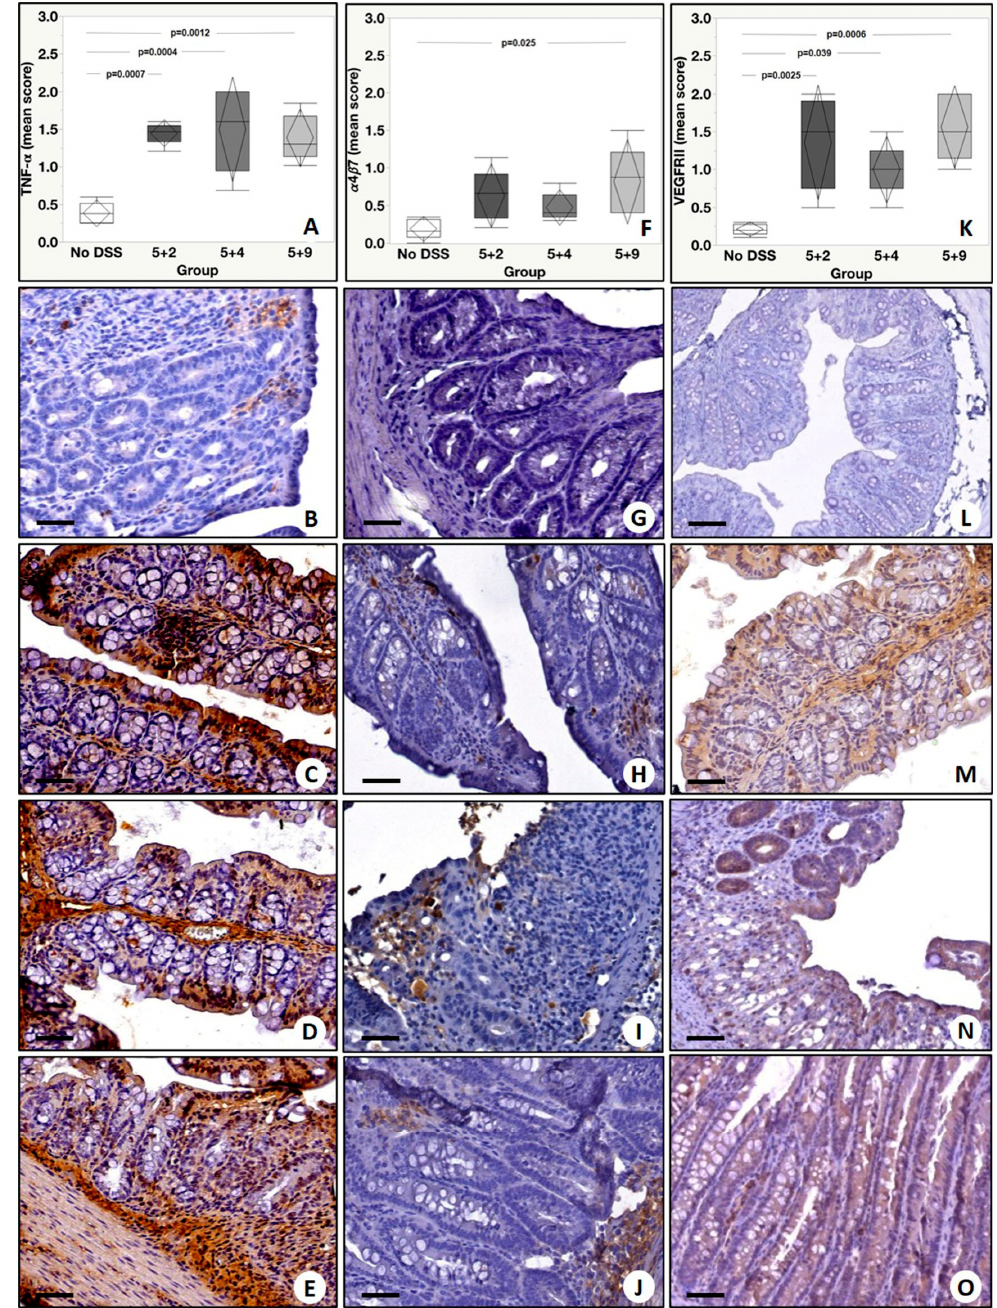
Figure 4. Immunohistochemical evaluation of the expression of TNF- α , α 4 β 7 and VEGFRII. ( A ) Graph shows the expression of TNF- α among the experimental groups. ( B ) No/rare TNF- α positive inflammatory cells are displayed. ( C – E ) Images show several TNF- α positive inflammatory cells in colons from 5 + 2, 5 + 4 and 5 + 9 mice. ( F ) Graph shows the expression of α 4 β 7 among the experimental groups. ( G ) No/rare α 4 β 7 positive inflammatory cells are displayed. ( H ) Moderate α 4 β 7 positive inflammatory infiltrate in a colon from 5 + 2 mouse. ( I ) Rare α 4 β 7 positive cells in a colon from 5 + 4 mouse. ( J ) High/moderate α 4 β 7 positive inflammatory cells in a colon from 5 + 9 mouse. ( K ) Graph displays the expression of VEGFRII among the experimental groups. ( L ) Colon of NO DSS mouse shows no/rare VEGFRII positive cells. ( M ) High VEGFRII positive inflammatory infiltrate in a colon from 5 + 2 mouse. ( N ) Image displays some α 4 β 7 positive cells in a colon from 5 + 4 mouse. ( O ) Moderate VEGFRII positive inflammatory cells in a colon from of 5 + 9 mouse. Scale bar represents 200 µm in each image.